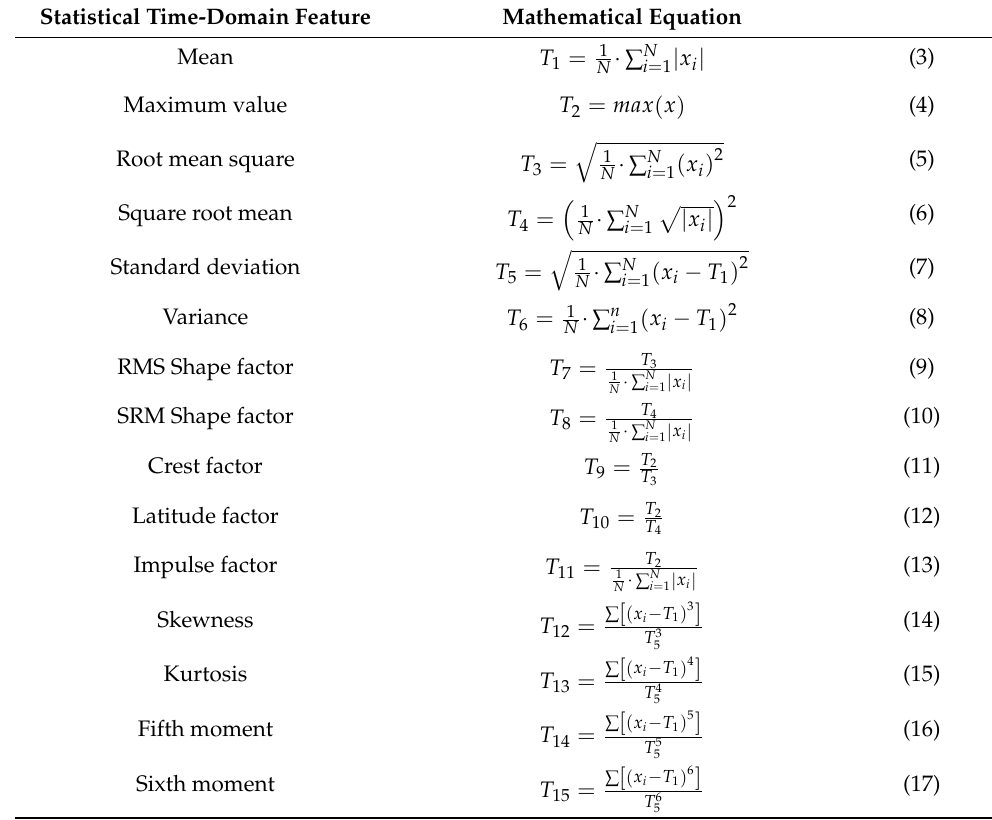
Table 1. The proposed set of statistical features for the characterization of the available signals during the processing in the time-domain analysis, where x(i) is a sample for i = 1, 2, . . . , N , and N is the number of points for each acquired signal.